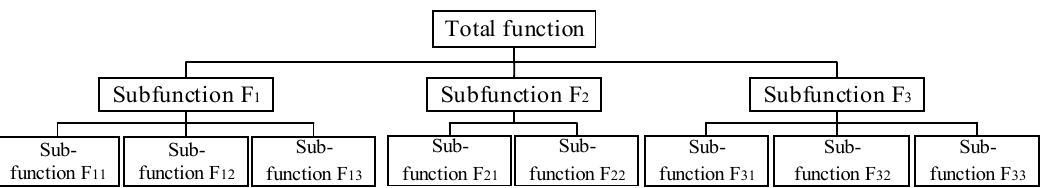
Figure 4. Proposed modeling process of the extended CWS.